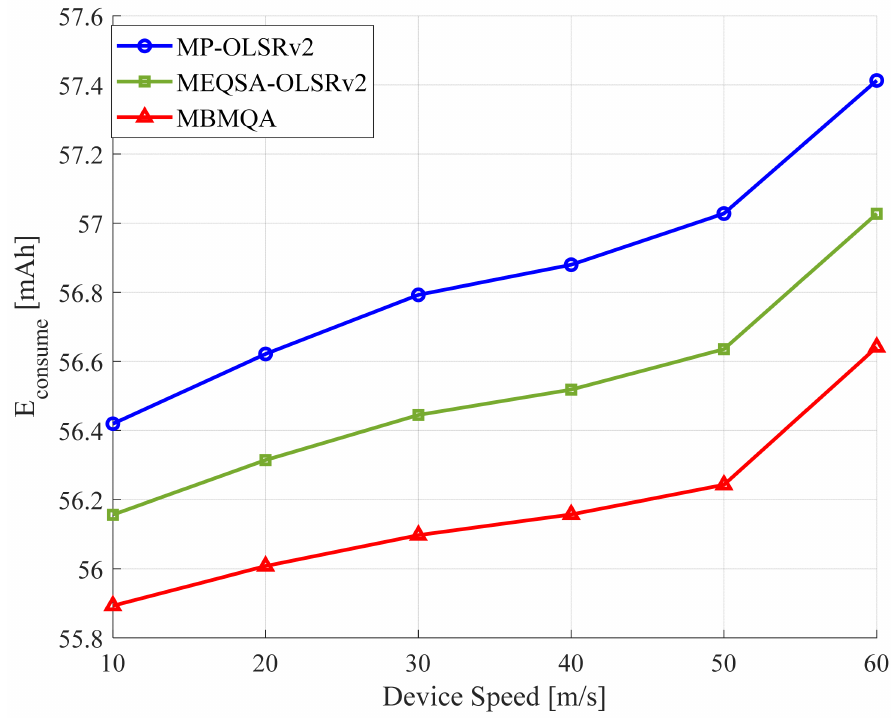
Figure 9. Energy consumption for various device